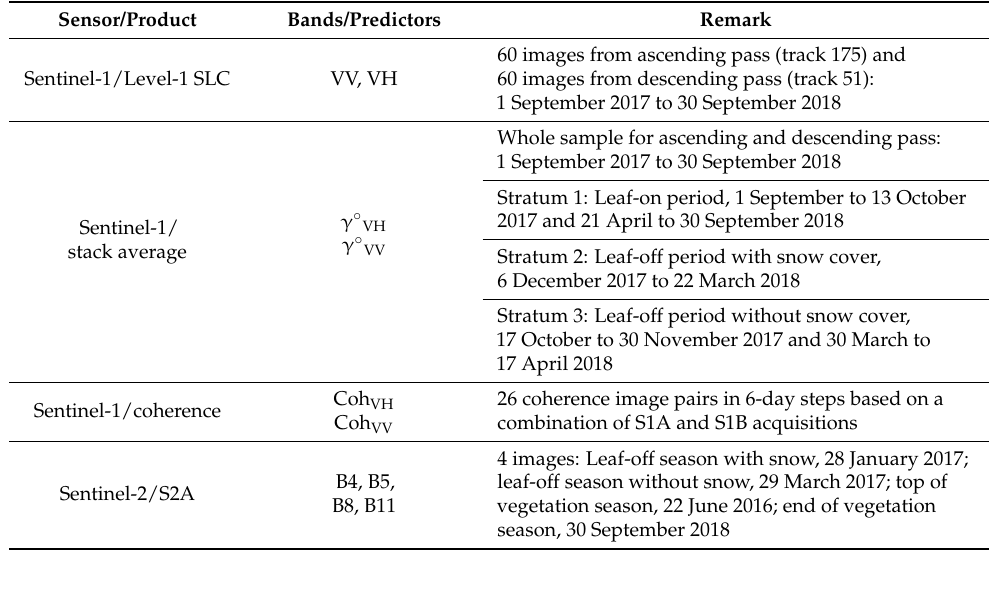
Table 3. Sentinel-1 and Sentinel-2 data and derived products used in the study.